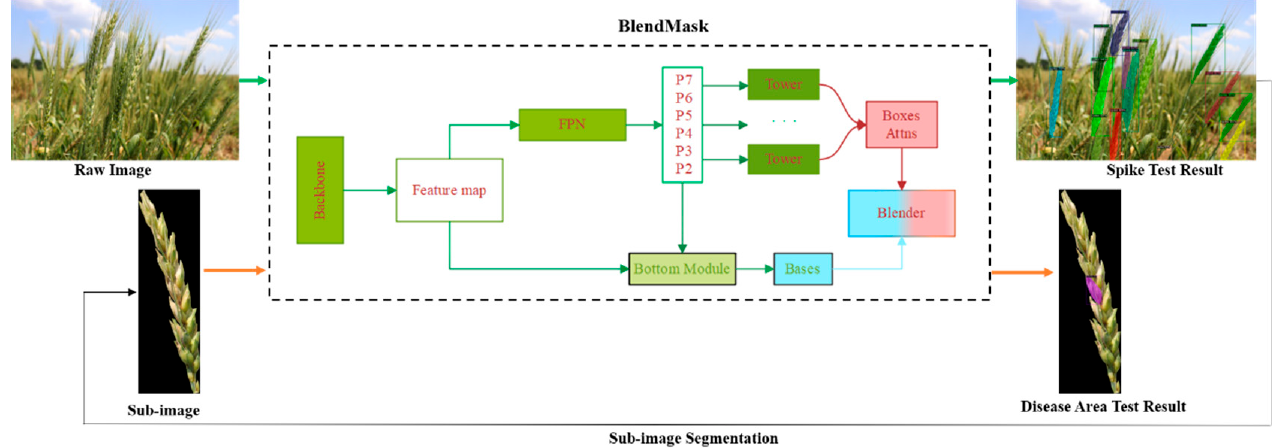
Figure 2. The architecture of the BlendMask approach for wheat Fusarium head blight (FHB) disease